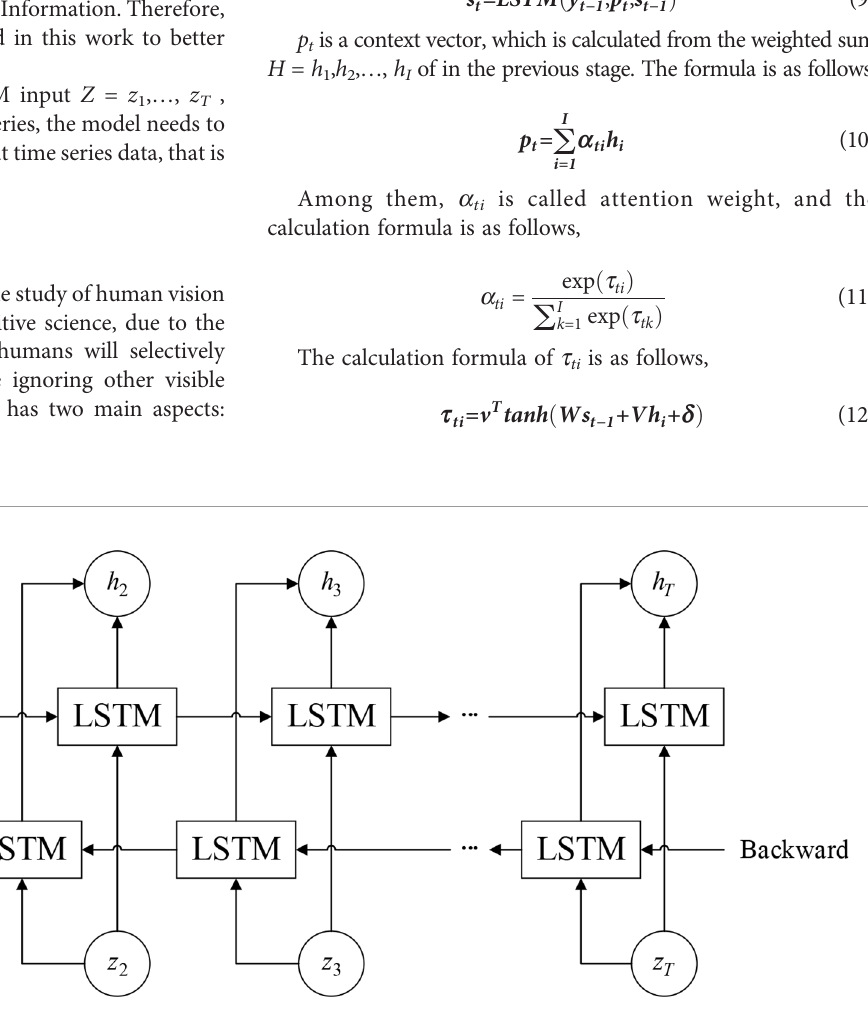
FIGURE 4 | Bi - LSTM module